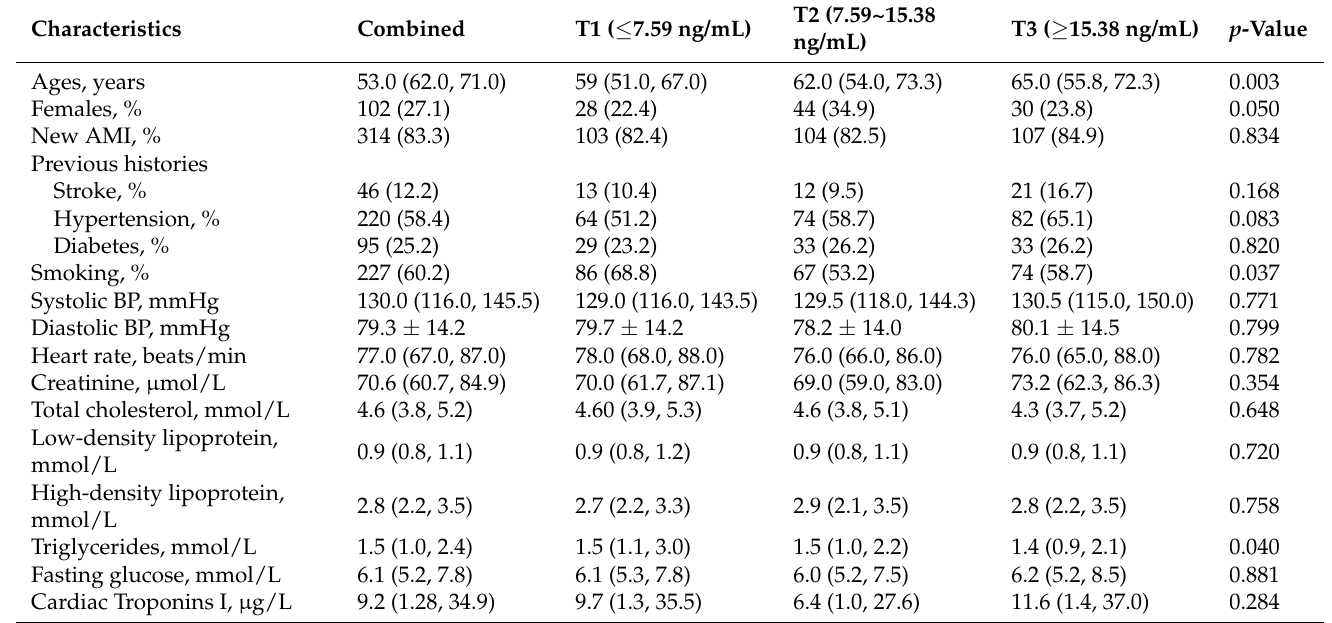
Table 1. Demographics for patients admitted to hospital with AMI stratified by spermidine